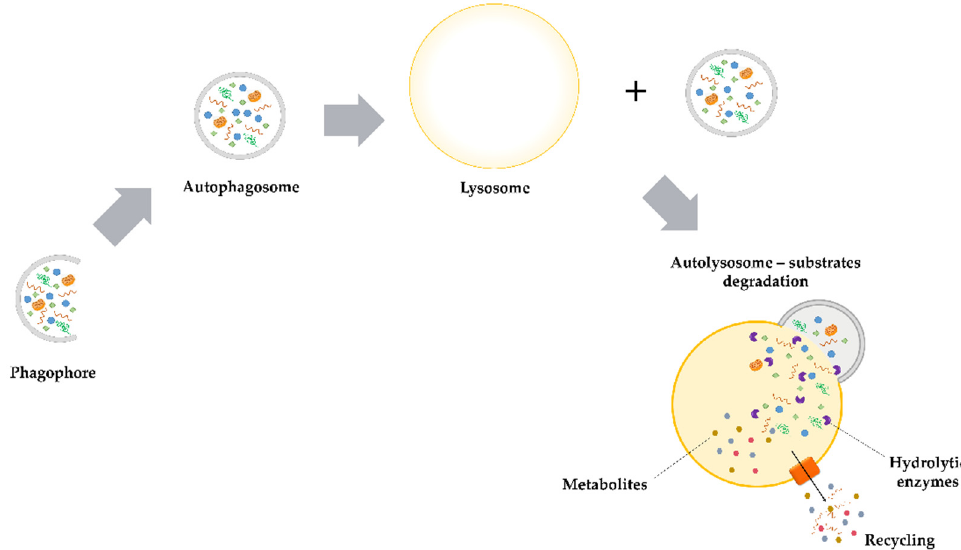
Figure 1. Macroautophagy. The C-shaped expansion of the double membrane results in the formation of an autophagosome. This small ‘vesicle’ contains redundant or damaged organelles, cellular fragments or proteins. In the next step, the formed autophagosome fuses with the lysosome and an autolysosome is formed. Inside the created structure, all components are degraded by hydrolytic enzymes.